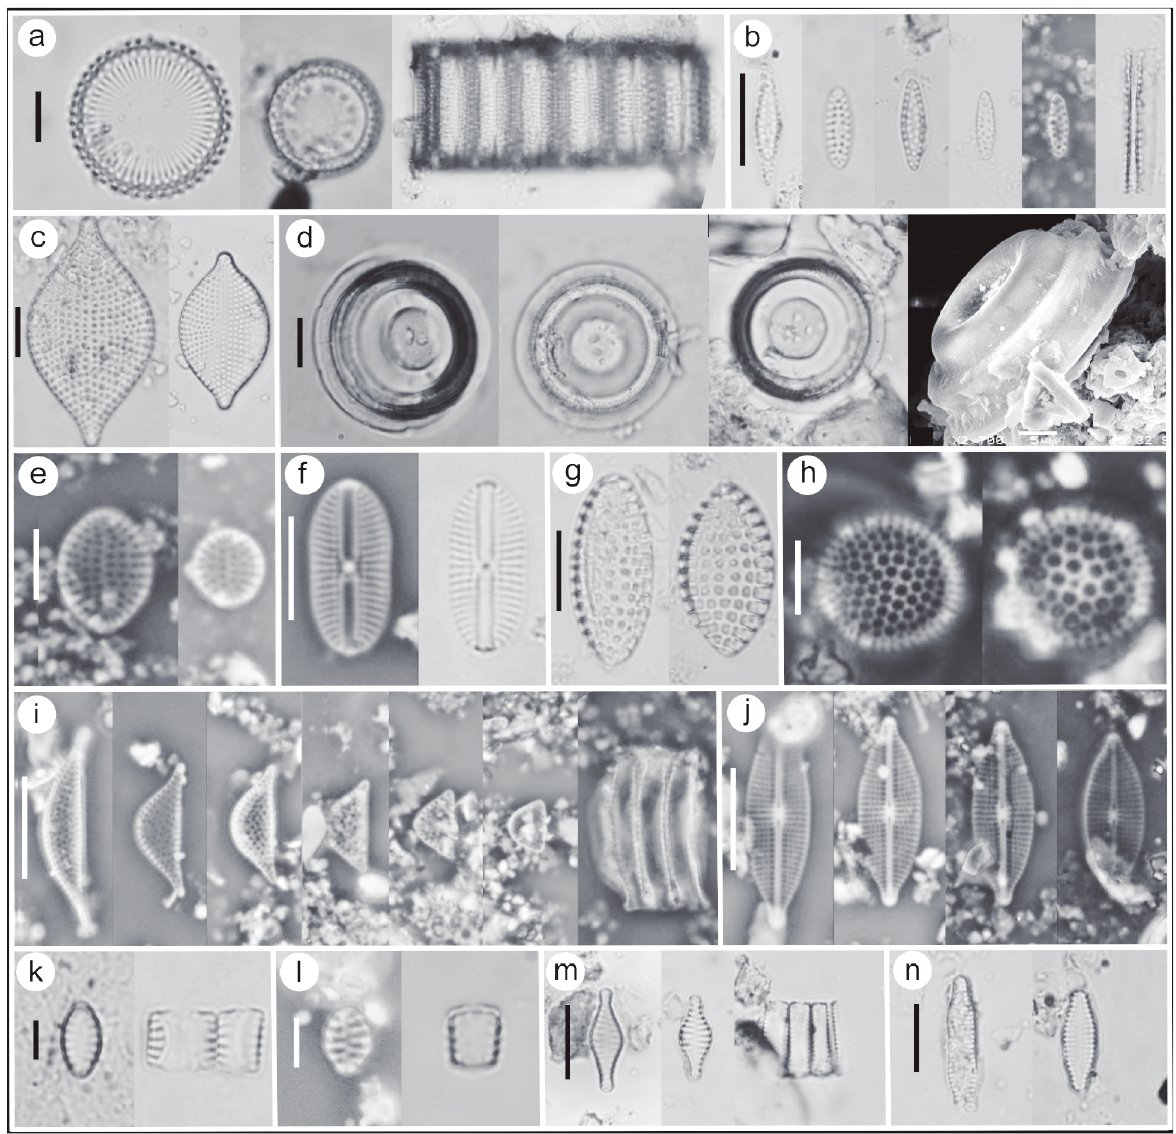
Figure 4. Light photomicrographs of Holocene diatoms taxa from the LCH core. a: Paralia sulcata ; b: Cymatosira belgica ; c: Rhaphoneis amphiceros ; d: Pseudopodosira boltovskoyi ; e: Delphineis minutissima ; f: Diploneis aestuarii ; g: Tryblionella granulata ; h: Schionodiscus oestrupii ; i: Campylosira cymbelliformis ; j: “naviculoid” taxon; k: Staurosira venter ; l: Punctastriata glubokoensis ; m: Punctastriata lancettula ; n: Staurosira binodis . Scalebar = 10µm (in c, h, k, l, scalebar = 5